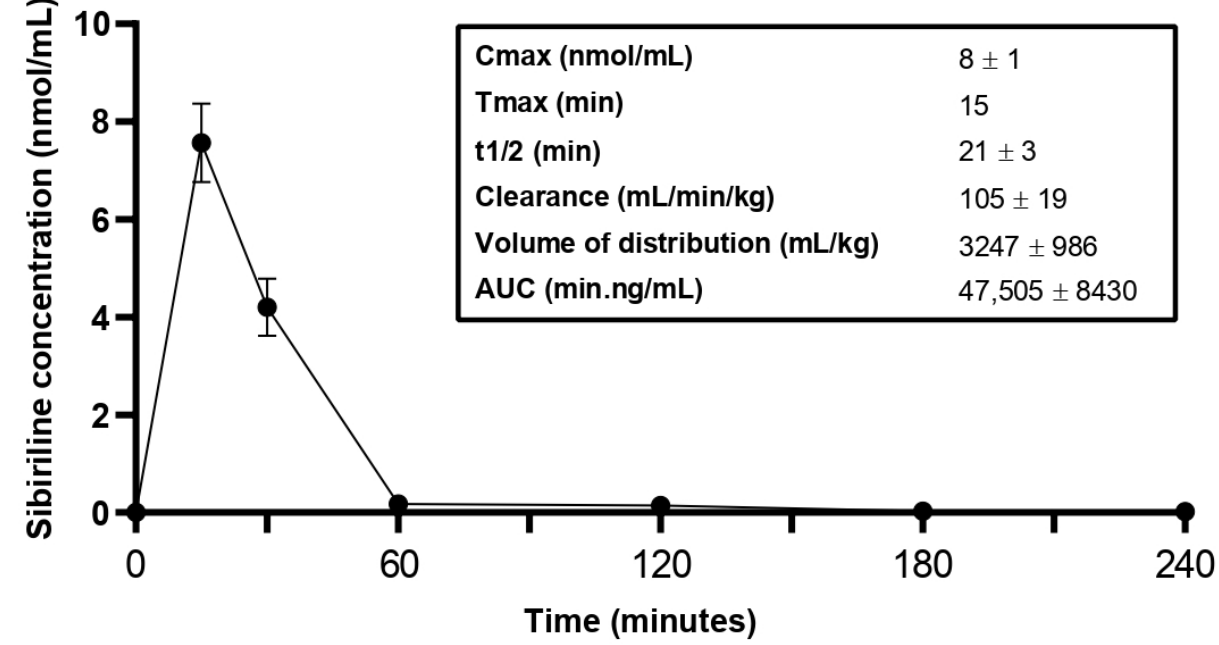
Figure 3. In vivo pharmacokinetics study of sibiriline. Evolution of the plasma concentration of sibiriline after intraperitoneal administration of sibiriline (5 mg/kg) in Swiss mice.